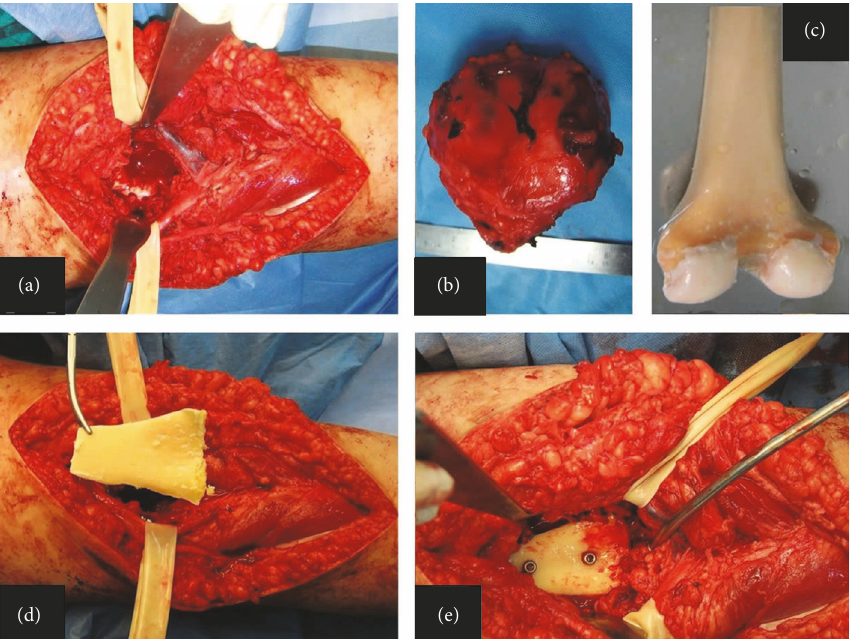
Figure 3: Intraoperative image of the popliteal fossa after tumor resection and identification of the tibia nerve and the popliteal artery (a). Hemicortical resection (b). The resected specimen (c). Distal femoral allograft (d). The part of the posterior femoral allograft matching the dimension of the posterior distal femoral defect after tumor excision (e). Two cortical screws were used to fix the allograft to the distal femur.